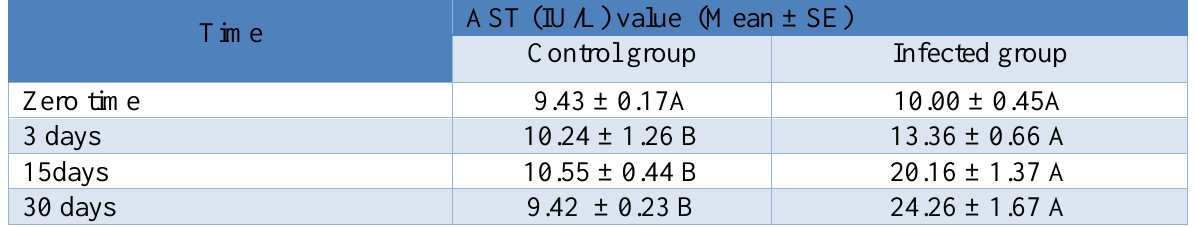
Effect of E.coli infection on AST (IU/L) value of infected group compared group at zero time, 3, 15 and 30 days post